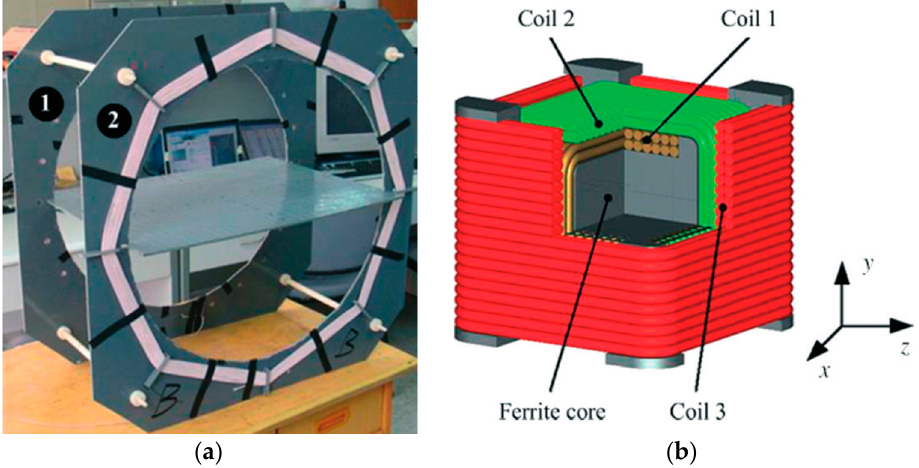
Figure 21. 3D WPT system for capsule endoscopy (CE) [122]. ( a ) Helmholtz TX coil. ( b ) Structure of the 3D receiver. Reproduced with permission from John Wiley and Sons, Copyright © 2010.